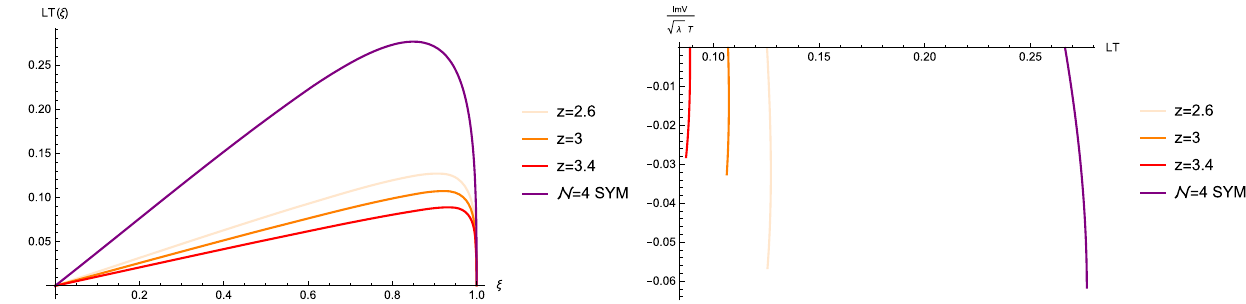
√ / λ T versus LT in the different z at θ = 2 and QQ